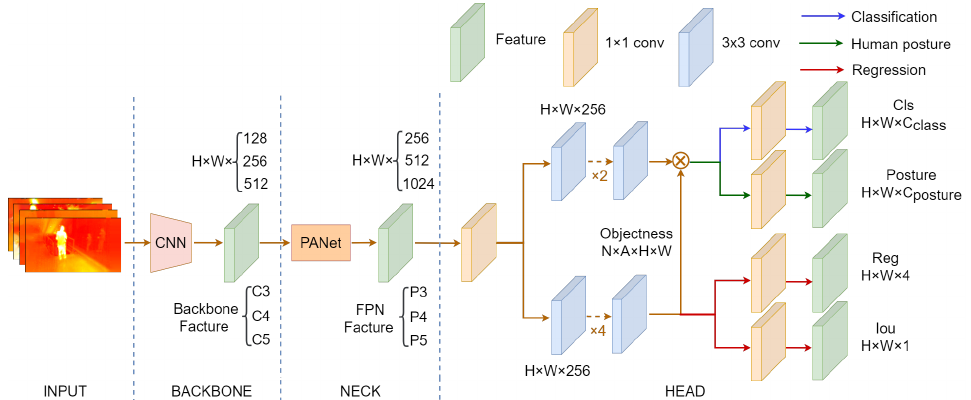
Figure 6. The generalstructure of the IPH-YOLOX detector we proposed. The network structure is a carryover from YOLOX [59] with the difference of an extra head that is utilized to predict human